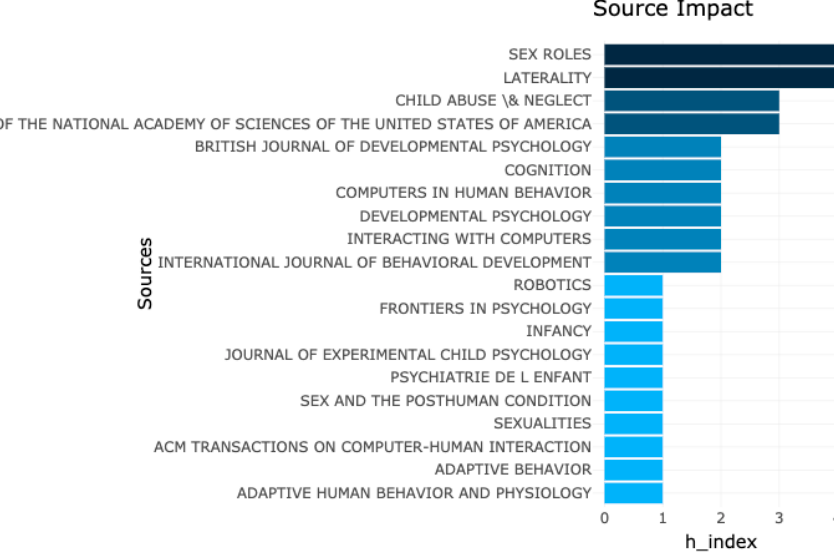
Table 1. Research question 1 (RQ1) about design approaches, type of study, and outcomes. Authors